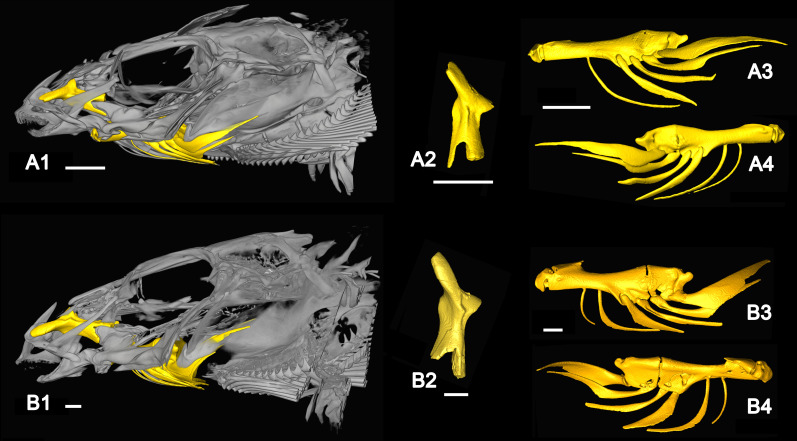
Anatomical position and details of the palatine, the ceratohyal bone, and the branchiostegal rays of Rhyacichthys guilberti.(A) MNHN 2019-0113-1, (A1) skull, (A2) left palatine, (A3) left ceratohyal with only five branchiostegal rays, (A4) right ceratohyal with six branchiostegal rays (all lateral view). (B) MNHN 2019-0113-2, (B1) skull, (B2) left palatine, (B3, B4) left ceratohyal in lateral (B3) and medial view (B4), each with six branchiostegal rays. All images based on μ-CT scanning. All scale bars 1 mm.